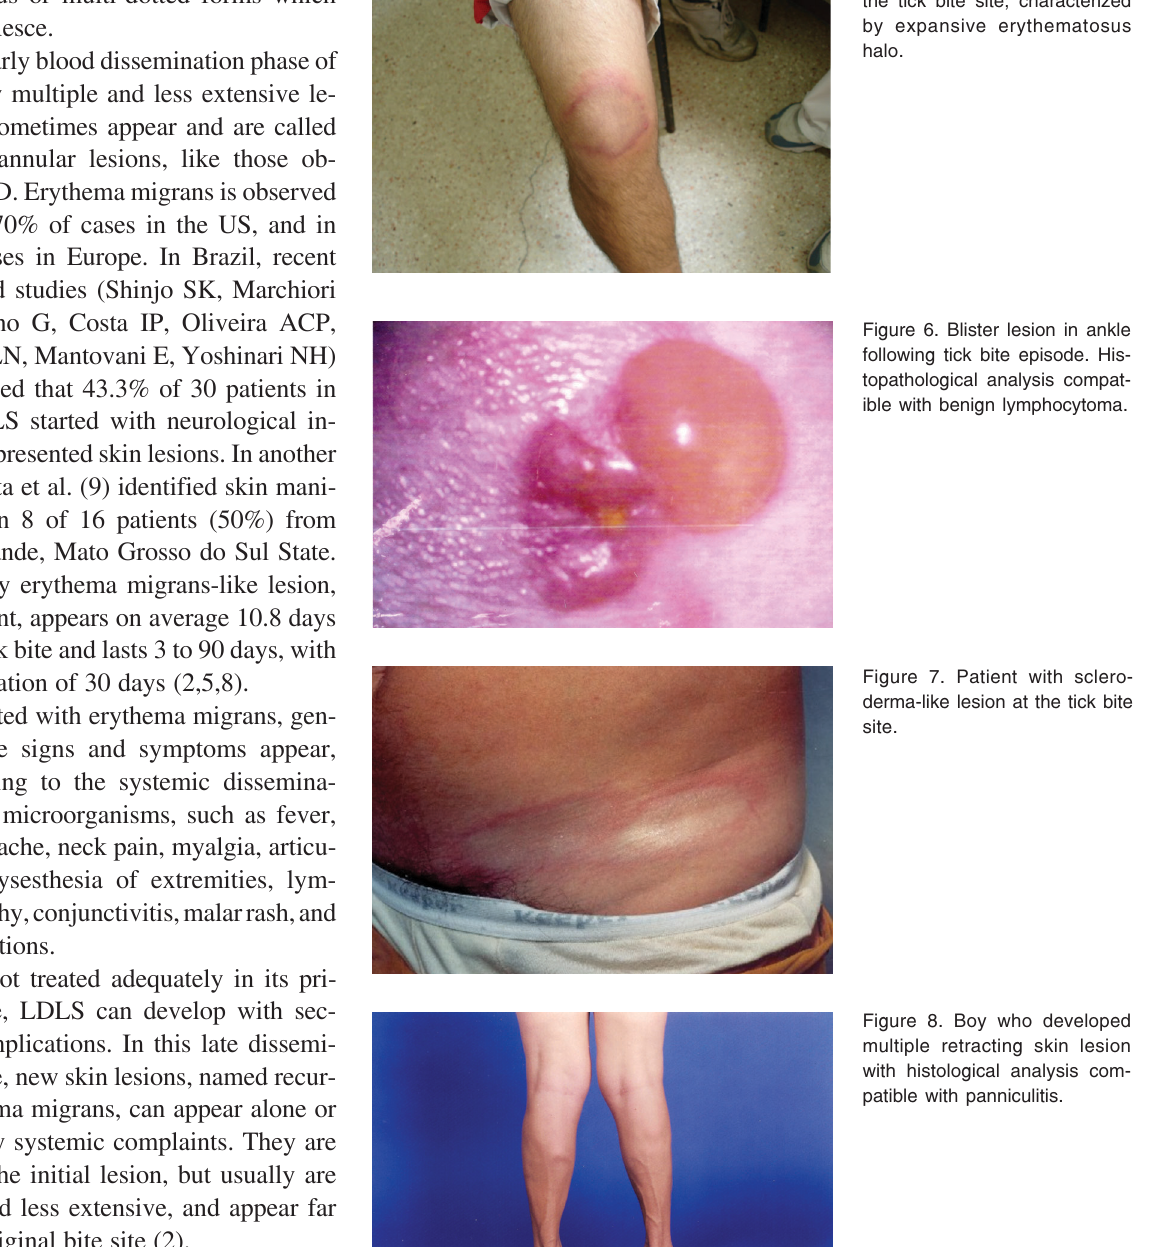
Figure 8. Boy who developed multiple retracting skin lesion with histological analysis com- patible with